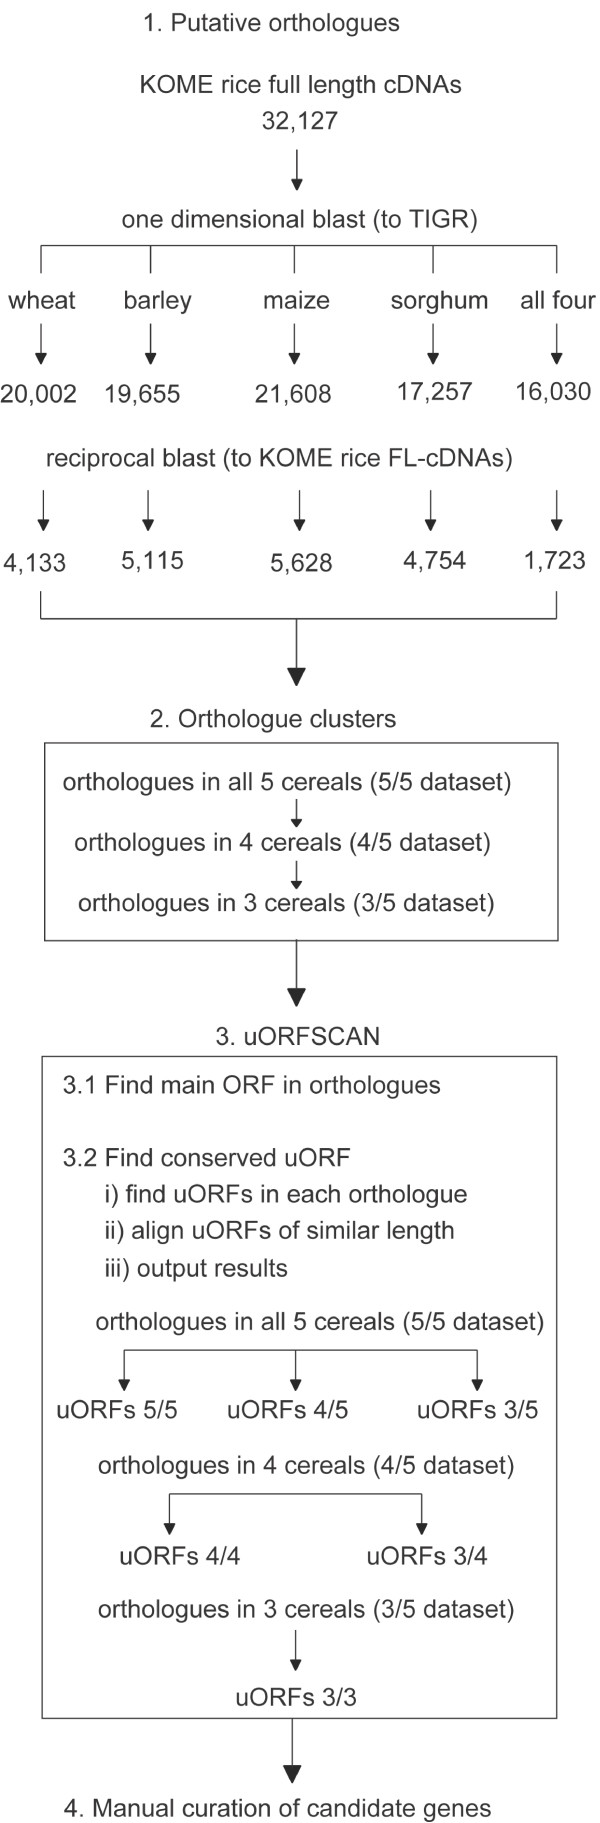
Tran_Figure1.eps. 'Overview of the uORFSCAN pipeline'. The pipeline consists of four steps: 1) Identifying putative orthologues using a modified reciprocal best hit (rbh) method, 2) Clustering of orthologues according to how many cereal species they are found in, 3) Using uORFSCAN program to find conserved uORFs using a comparative approach, and 4) manual curation of predicted conserved cereal and Arabidopsis uORFs.